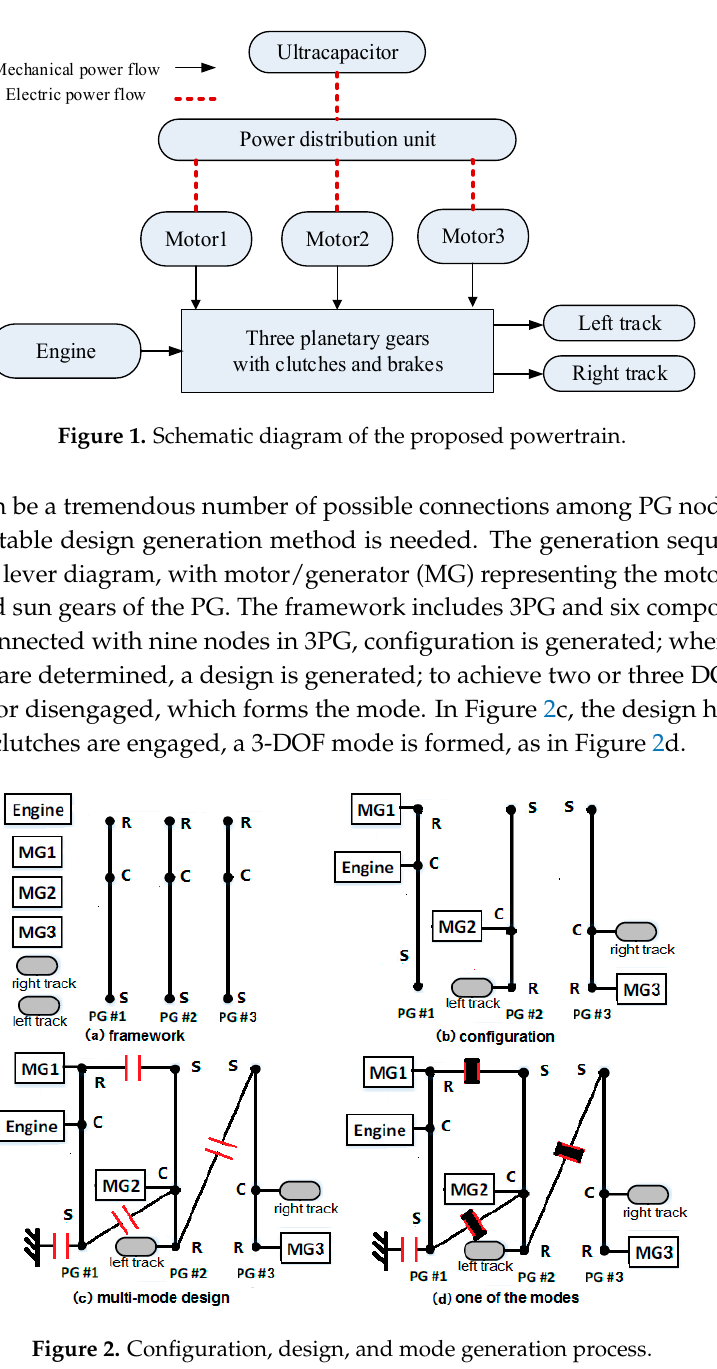
Figure 2. Configuration, design, and mode generation process.